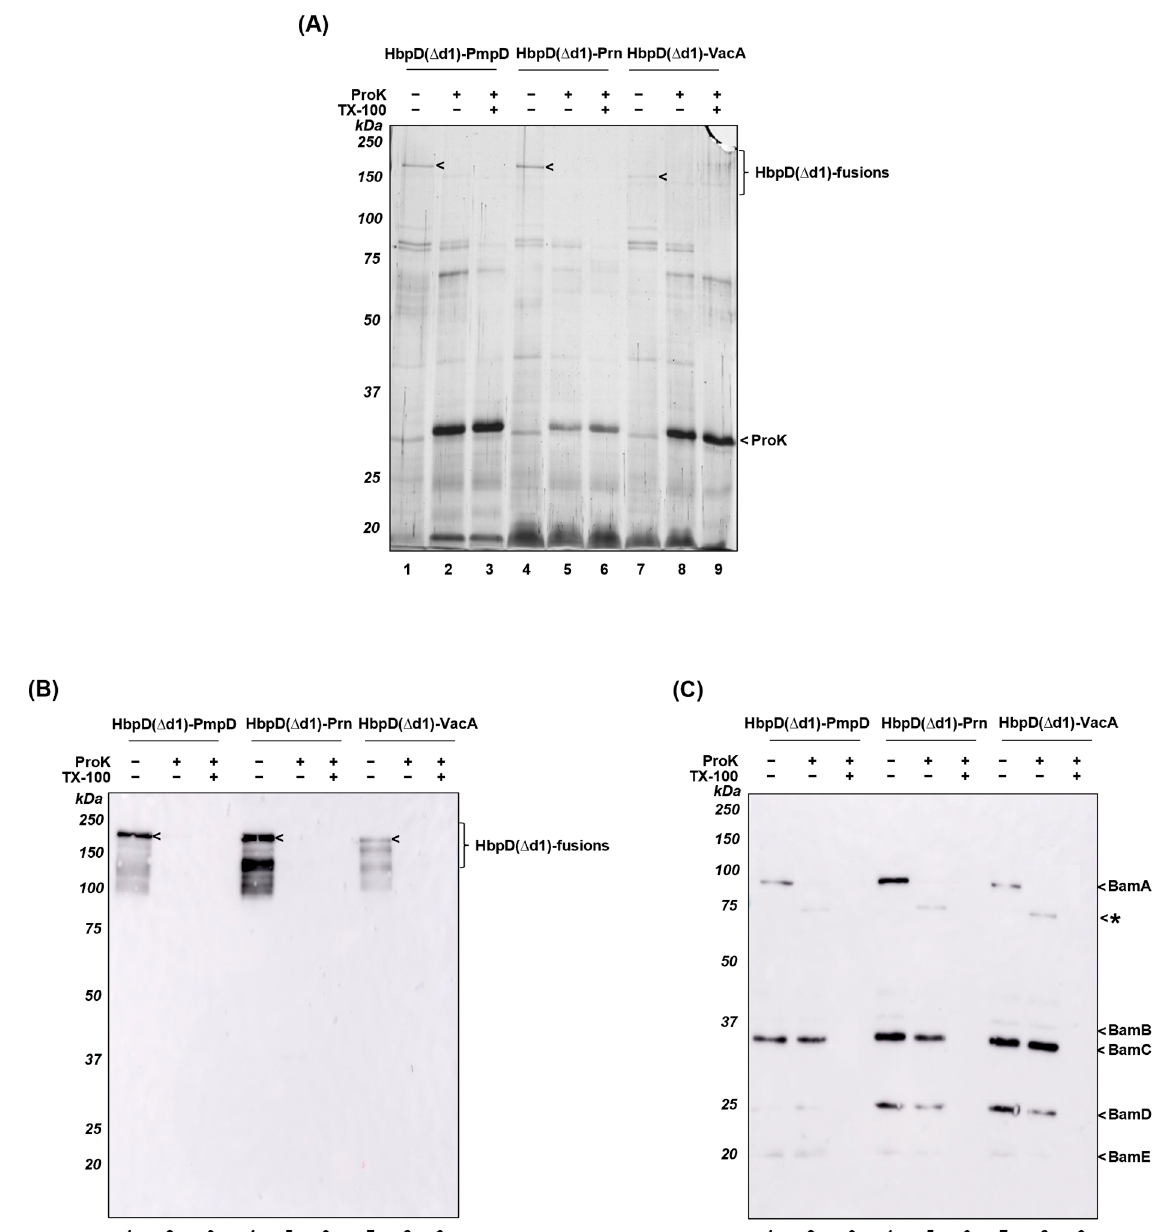
Figure 3. Display of HbpD( ∆ d1)-PmpD, HbpD( ∆ d1)-Prn and HbpD( ∆ d1)-VacA at the surface of E. coli OMVs. Equivalent amounts of BL21(DE3)omp8 OMVs expressing HbpD( ∆ d1)-PmpD; HbpD( ∆ d1)-Prn and HbpD( ∆ d1)-VacA were used for a proteinase K (ProK) accessibility assay. Samples of untreated intact OMVs, intact OMVs treated with ProK and lysed OMVs, treated with TritonX-100 (TX-100) and incubated with ProK were analyzed by SDS-PAGE followed by silver staining ( A ) or immunoblotting using Hbp antiserum ( B ) or antiserum recognizing the E. coli Bam complex ( C ). In the panel ( C ) bands representing truncated BamA were indicated (*). MW markers (in kDa) are indicated at the left and identified protein bands at the right side of panels.